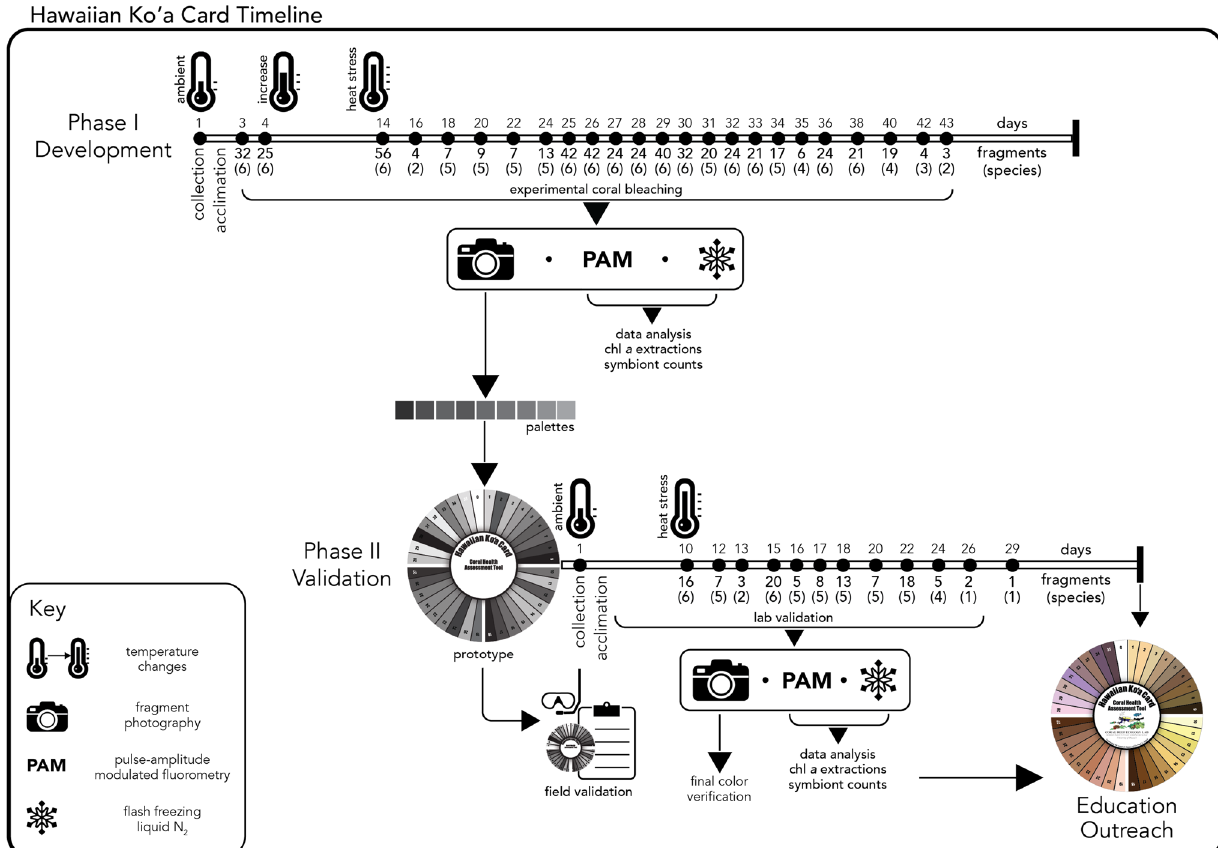
Fig. 1 Timeline and sequency of methodology in developing and validating the Hawaiian Ko ʻ a